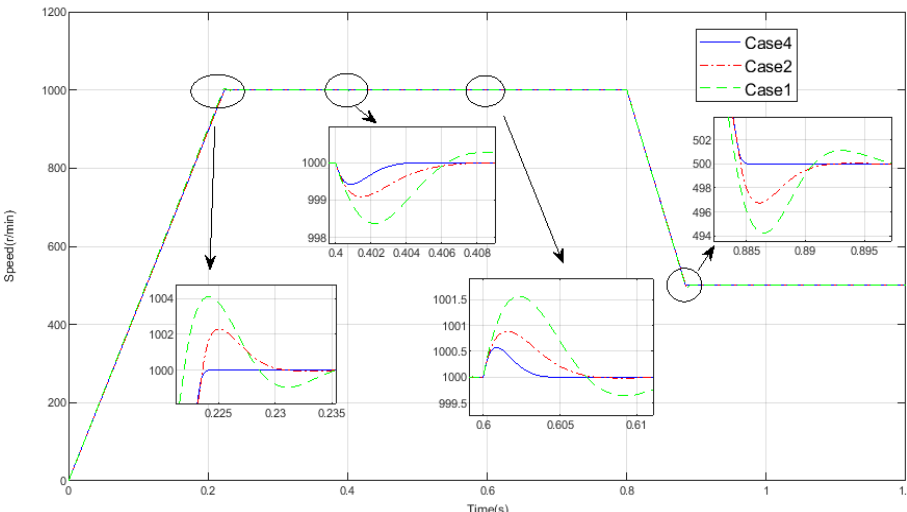
Figure 3. The comparison of the speed response in Case 1, Case 2 and Case 4.